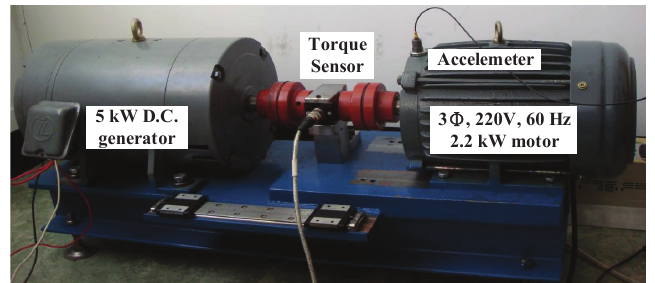
Figure 5. Experimental set-up.